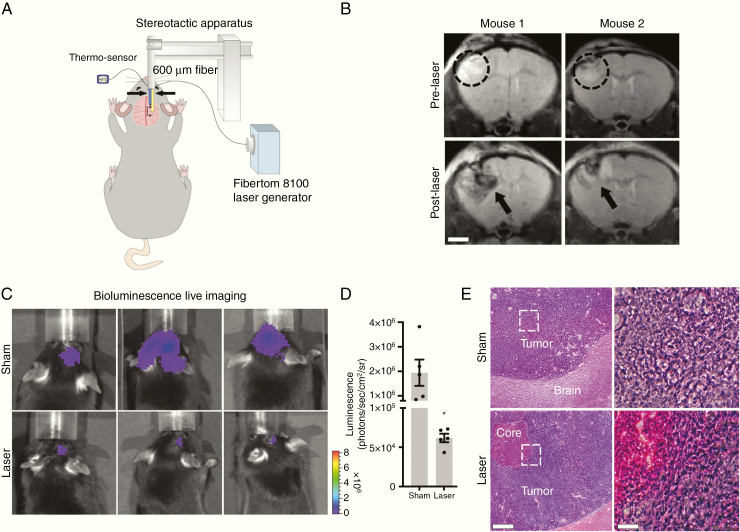
Establishment of a LITT mouse model. (A) Schematic depiction of the LITT delivery system in mice. The laser fiber (right arrow) is positioned 1 mm caudal to the thermo-sensor (left arrow). (B) Animals stereotactically implanted with GL261 tumor cells were subjected to MRI 7 days later. Representative T2-weighted MR images of 2 mice before and 24 h after LITT are shown. Tumor (dashed circle) and LITT-treated area (black arrow) are highlighted (n = 3 for each). Scale bar = 2 mm. (C) Animals stereotactically implanted with luciferase-expressing GL261 tumor cells were treated 8 days later with LITT or sham. (D) Tumor volume was quantified by BLI 3 days posttreatment. LITT-treated animals had significantly lower tumor burden compared to sham (n = 5 for each condition, unpaired t-test, *P < .01). (E) Representative H&E stained sections of sham (top) and laser-treated (bottom) mouse brains are shown (n = 3 for each condition). Loss of nuclear hematoxylin staining and enhanced eosin staining are observed in the necrotic laser core. Scale bar = 500 µm, 100 µm.